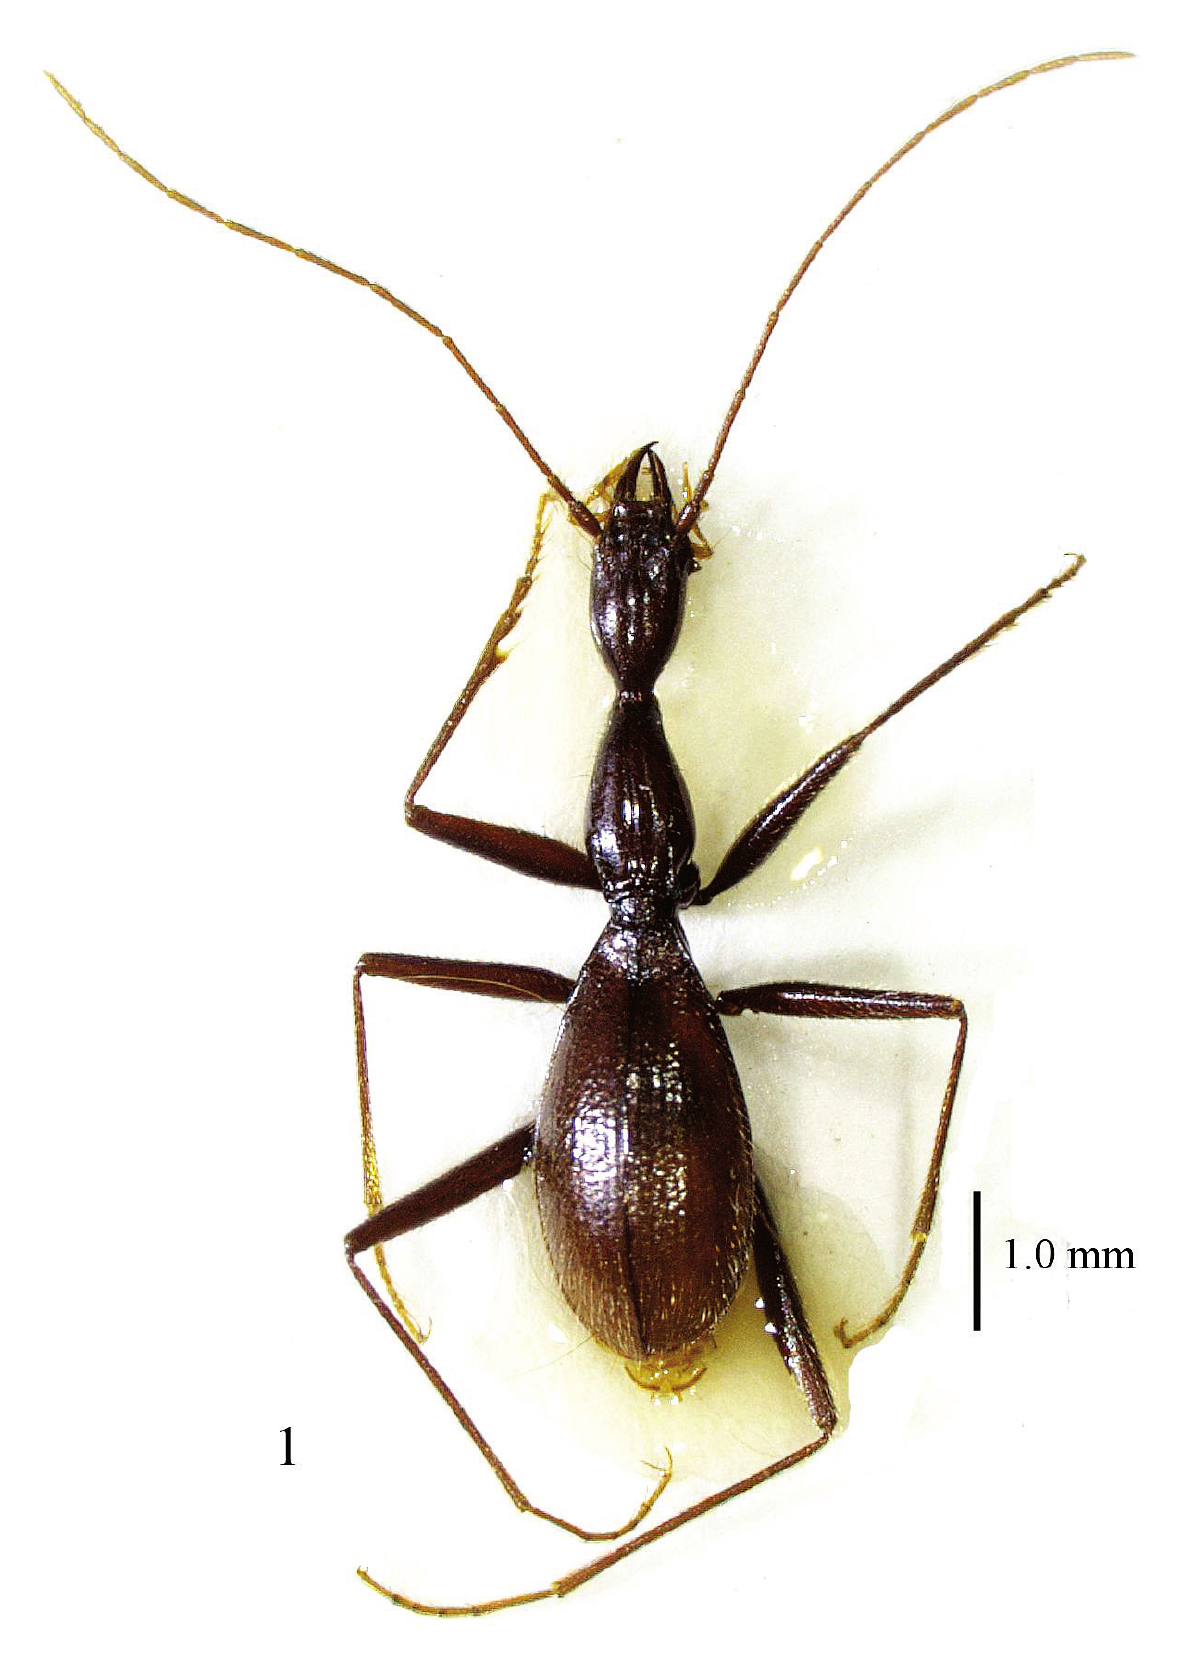
Fig. 1 - Dongodytes (Dongodytodes) deharvengi , subgen. and sp. nov., habitus (paratype, female, photographed by Gao